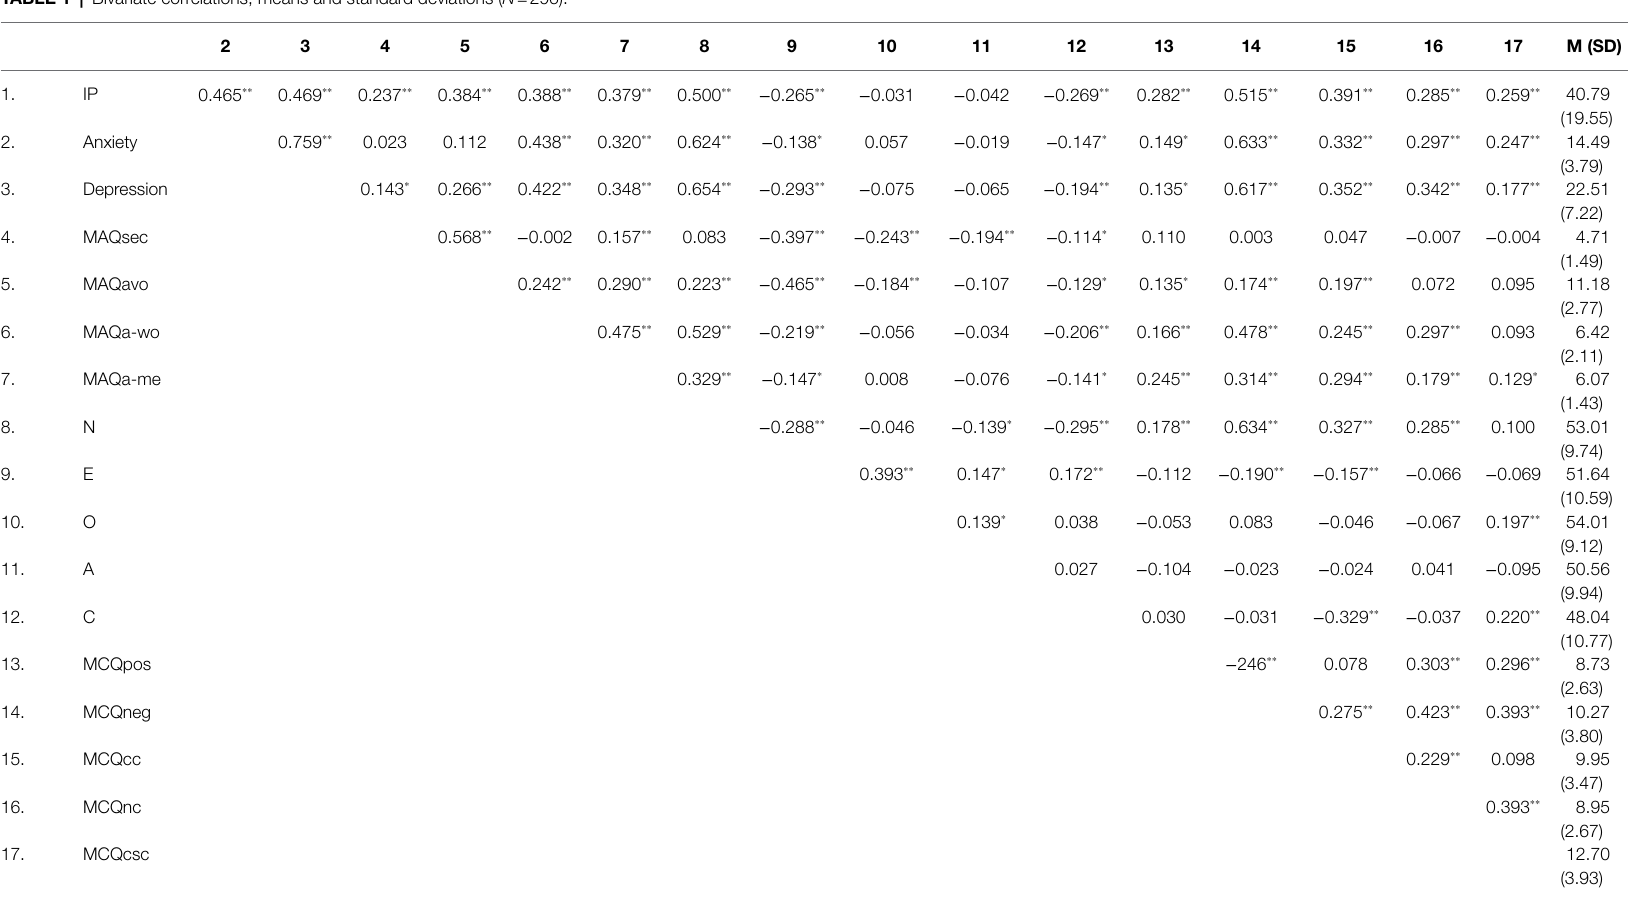
TABLE 1 | Bivariate correlations, means and standard deviations ( N =